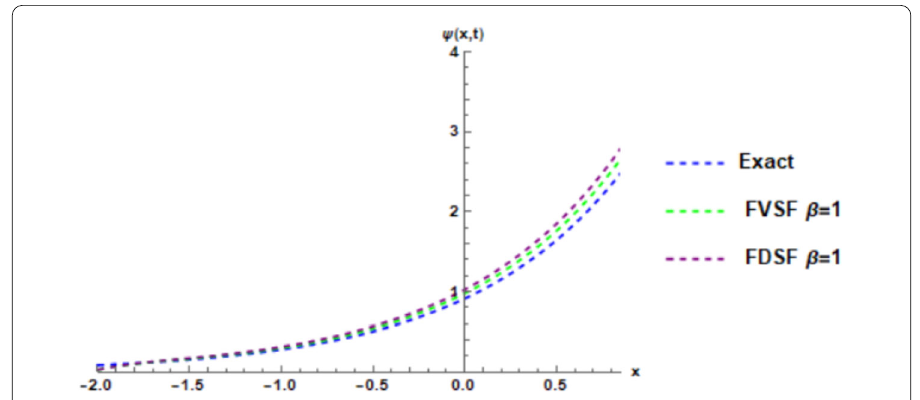
Figure 5 Exact and approximate solutions using FDSF and FVSF for Example 2 at time t = 1 and β = 1